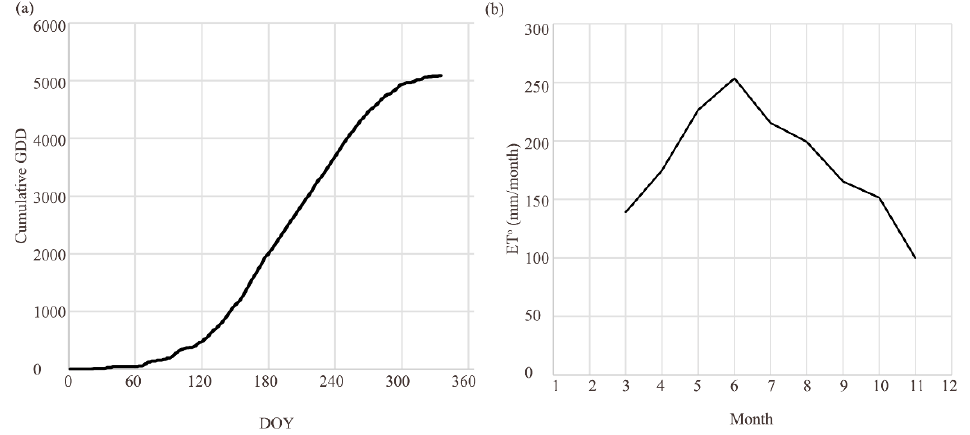
Figure 3. ( a ) Cumulative growing degree days (GDD) at base 50, and ( b ) reference evapotranspira- tion in for the Artesia Agricultural Science Center in